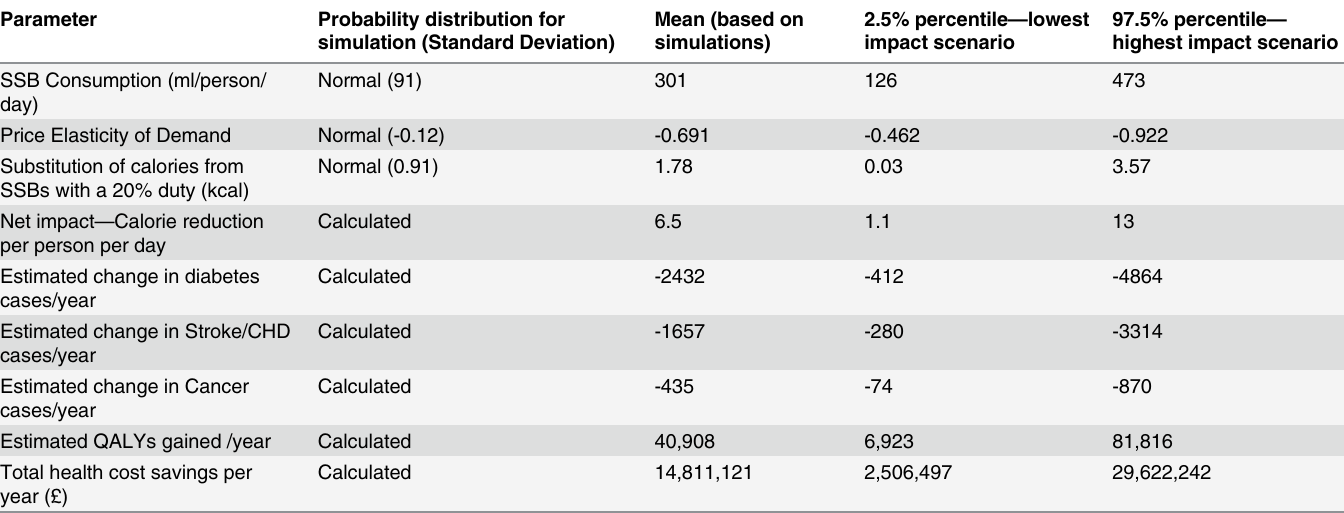
Table 4. Results from Monte Carlo simulation model for